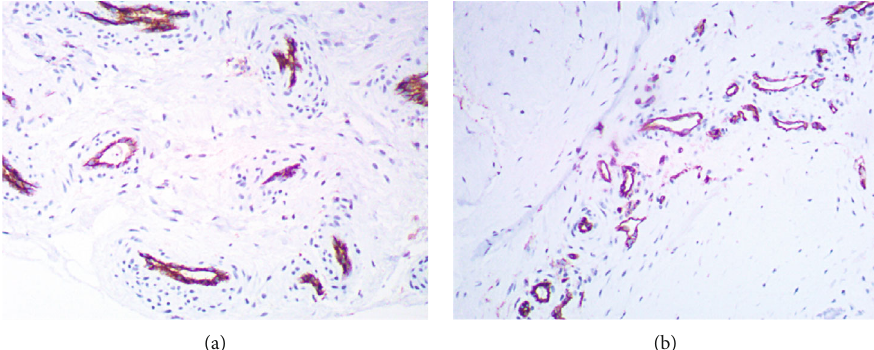
Figure 6: The representative microphotographs showing CD31 antigen expression in examined synovial membrane slices. (a) Synovial membrane from hemophilic arthropathy patient ( × 100 magni fi cation). (b) Synovial membrane from osteoarthritis patient ( × 100 magni fi